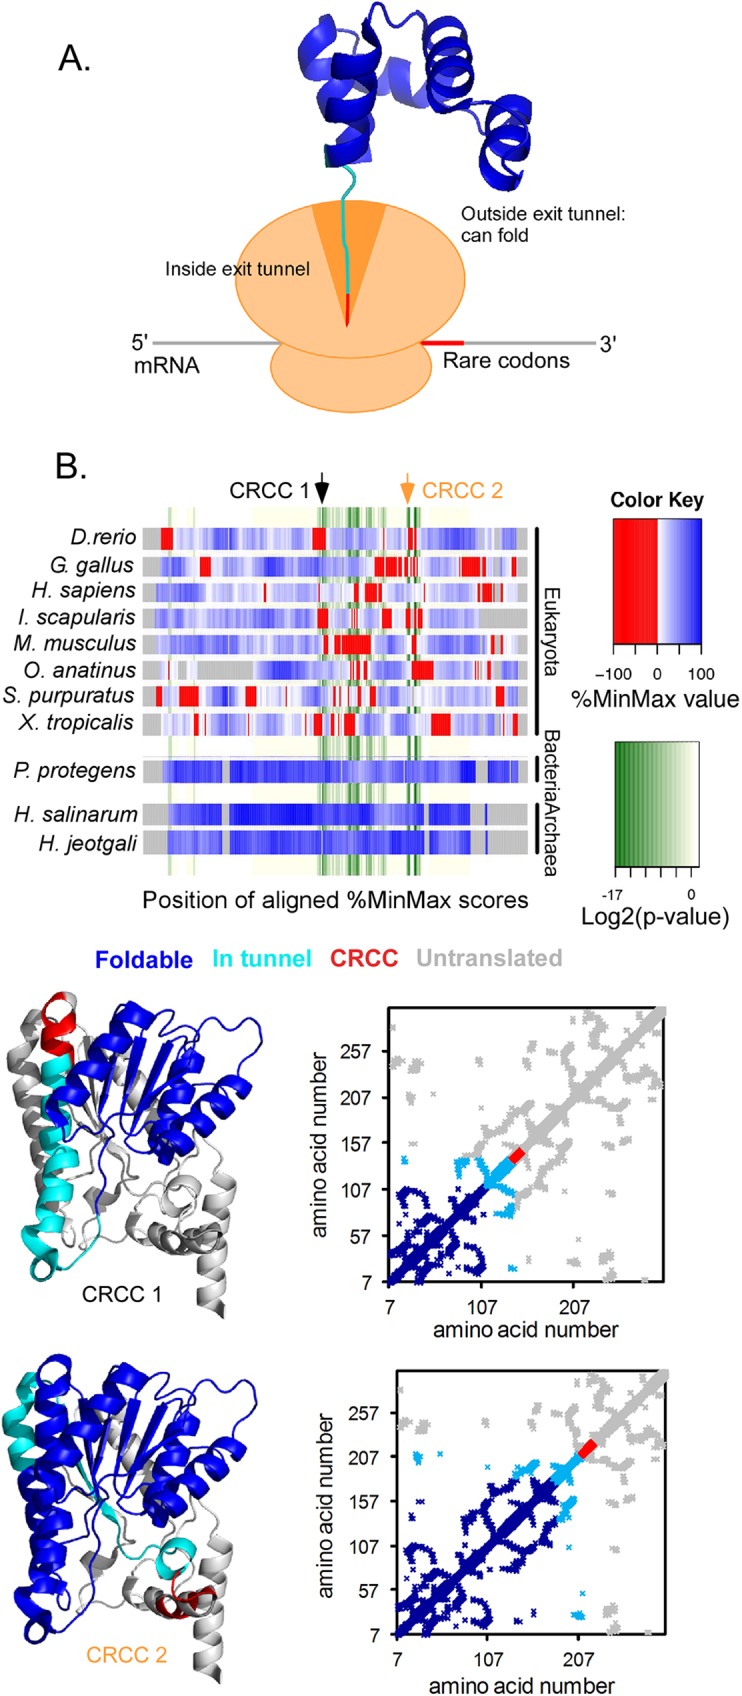
Connections between CRCC locations and co-translational folding units.(A) Schematic depicting the relative locations of a CRCC (red) to the portions of the nascent chain that have passed through the constriction of the ribosome exit tunnel (dark blue), versus the portion that remains within the tunnel (cyan). Ribosome is shown in orange. (B) A homolog family (peroxisomal trans 2-enoyl CoA reductase) with conserved rare codons. The heatmap represents the multiple sequence alignment of homologous protein sequences and indicates the location of rare codons within the alignment (clusters of rare codons are shown in red, regions with more common codons in blue). P-values for co-occurrence of rare codons in the sequence alignment are shown in a separate color scale (minimum p-value = 5E-6, indicated by dark green). The structure of the human homolog is shown (PDBID 1YXM). The structure is color-coded to indicate regions of the structure that would be outside the ribosome exit tunnel and able to fold at two of the possible rare codon-induced translational pauses: when the CRCC (red) is being translated, the N-terminal region of the protein (dark blue) would be able to fold. Locations of these CRCCs are indicated on the alignment by arrows. The contact maps indicate amino acids that are in contact (distance ≤ 6 angstroms) in the three-dimensional structure.